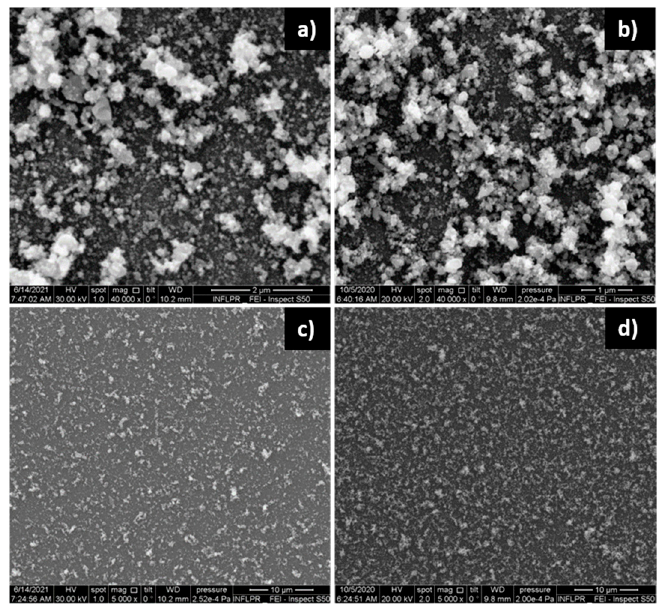
Figure 5. SEM images, at two magnifications, of ZnO films deposited in 700 mTorr O 2 with 0.2 W using 1.06 µm ( a , c ) and 532 nm ( b , d ) laser emission wavelength.